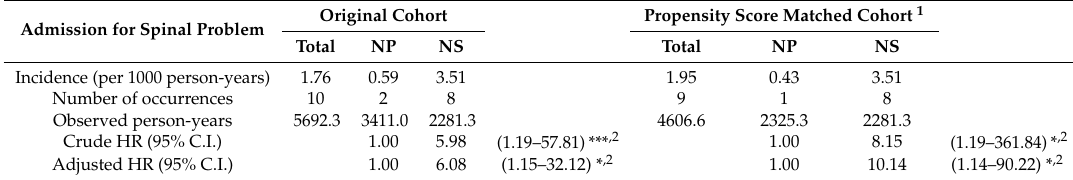
Table 2. Incidence rates and hazard ratios for spinal problems in NP and NS in original cohort and propensity score matched cohort (1998–2013).